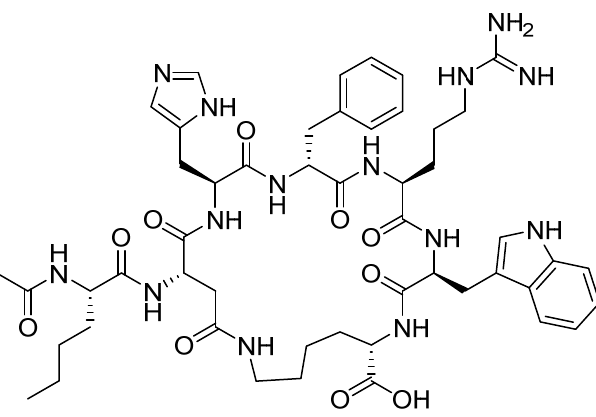
Figure 6. Chemical structure of bremelanotide (Vyleesi TM ).